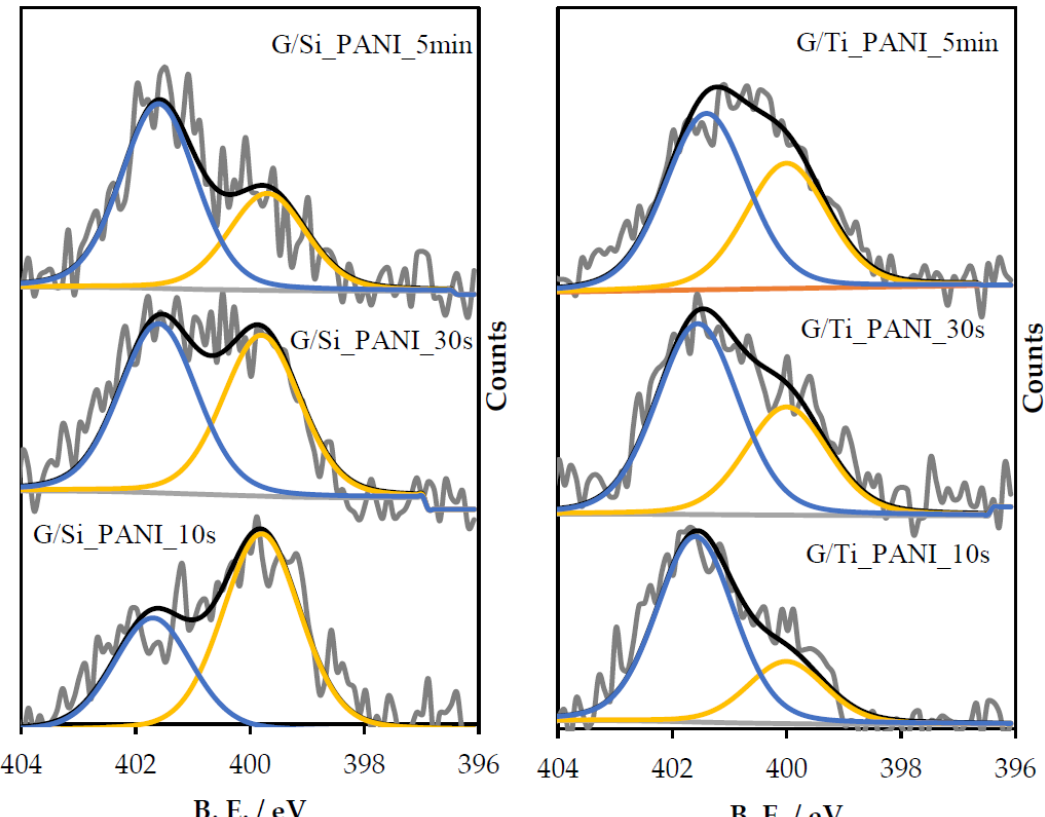
Figure 4. N1s spectra of all resultant G/Si-PANI-X and G/Ti-PANI-X samples. The blue line represents positively charged nitrogen, whereas the yellow line is associated with neutral amine species.